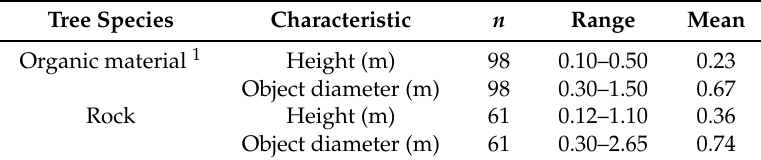
Table 2. Summary of field measurements of non-tree objects.